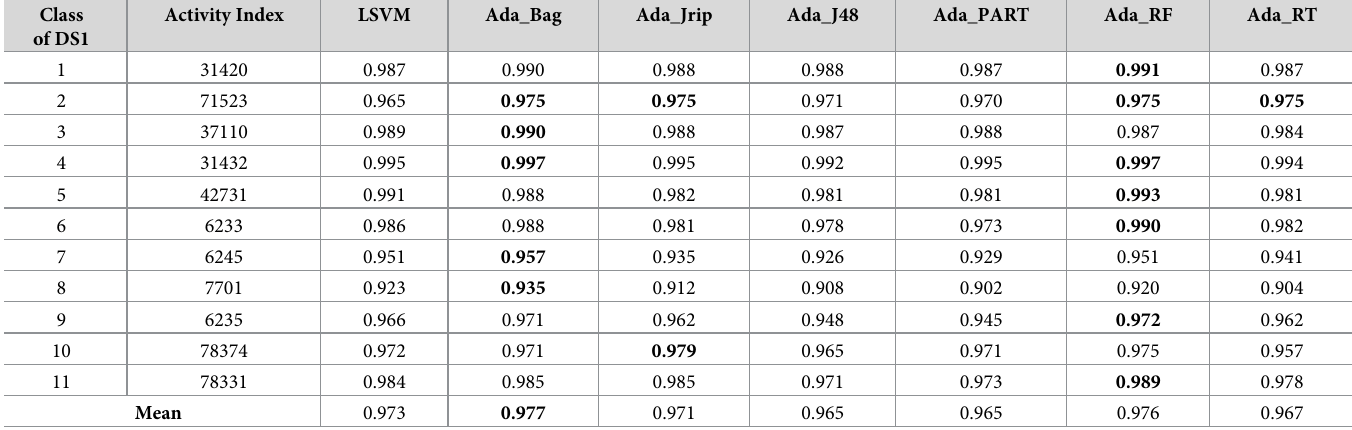
Table 10. AUC measure for the prediction of new bioactive molecules with DS1 (normal